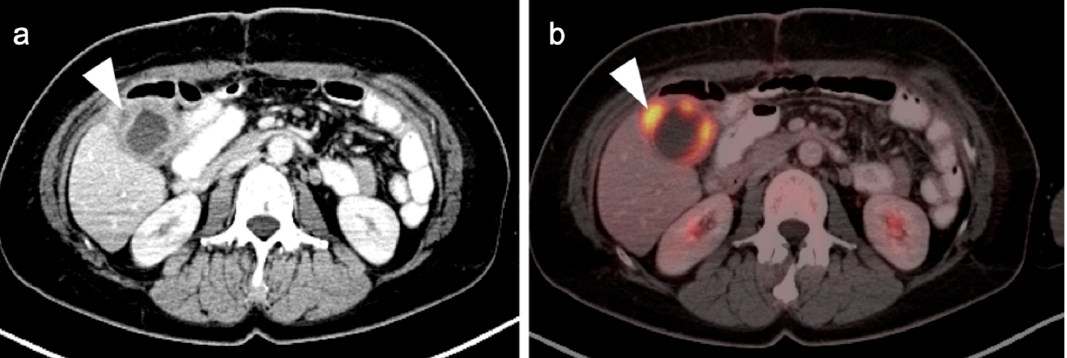
Figure 23. Xanthogranulomatous cholecystitis. ( a ) Contrast-enhanced CT demonstrates gallbladder wall thickening with nodular hypoattenuating regions within the gallbladder wall (white arrow- head); ( b ) Axial FDG PET-CT shows focal increased metabolic activity in the hypoattenuating nodular regions within the gallbladder wall, due to accumulation of lipid laden macrophages in areas of chronic inflammation (white arrowhead).